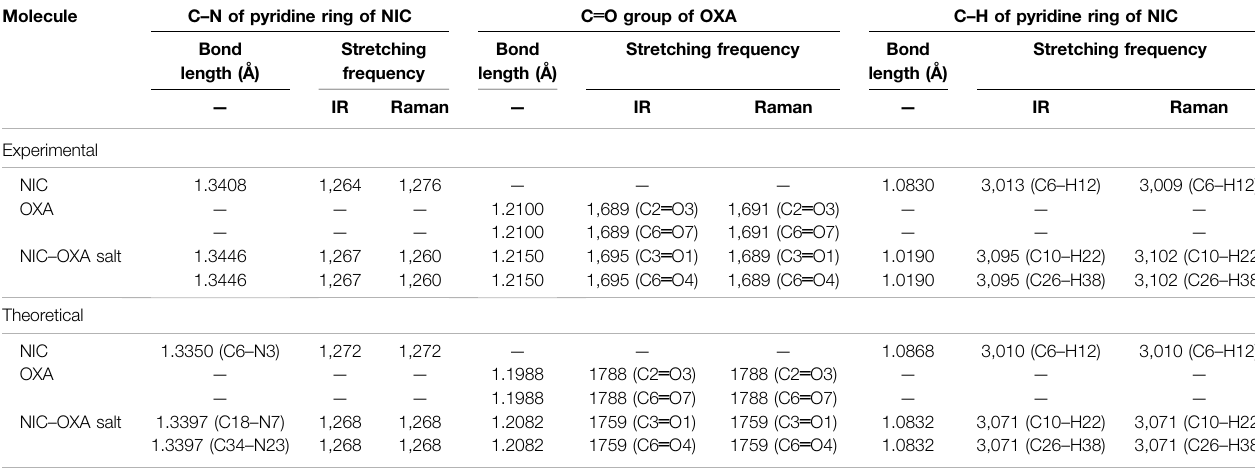
TABLE 1 | Observed and calculated bond length and stretching frequency of modes involved in hydrogen bonding.